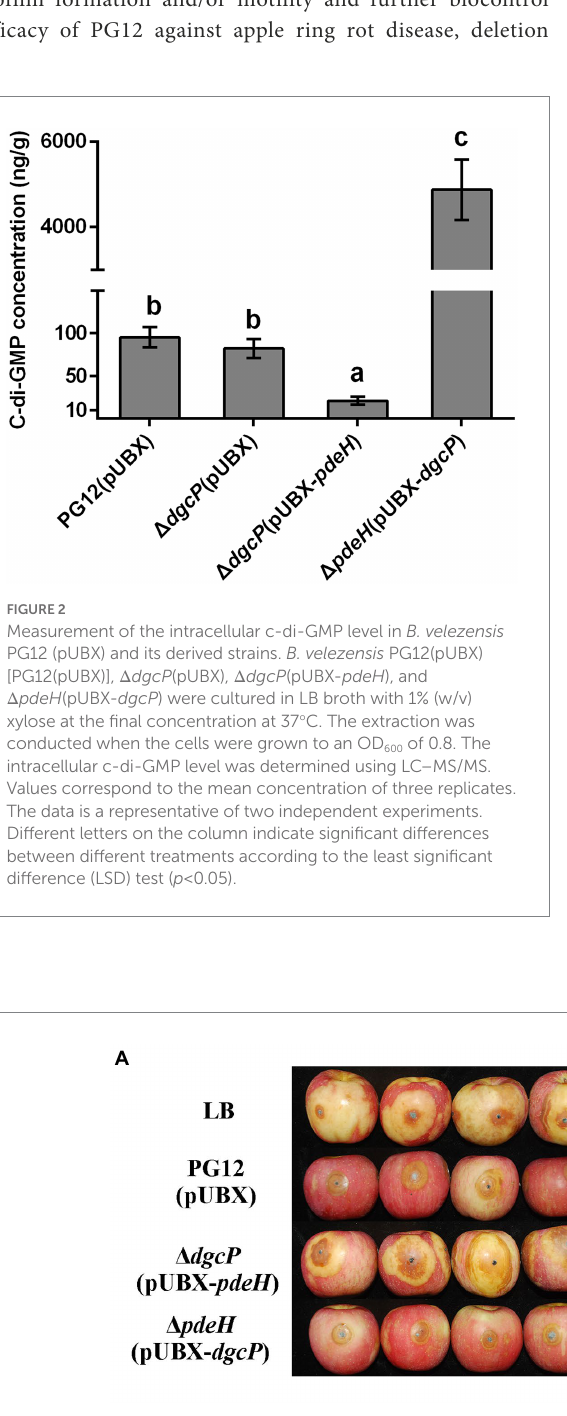
FIGURE 3 Artificially elevated or reduced c-di-GMP changes the biocontrol efficacy of B. velezensis against apple ring rot disease. Bacteria were incubated for 48 h in LB broth supplemented with 1% (w/v) xylose at the final concentration. Biocontrol efficacy was assessed with Fuji apple fruits treated with the cultures of B. velezensis PG12(pUBX) [PG12(pUBX)], Δ dgcP (pUBX- pdeH ) or Δ pdeH (pUBX- dgcP ). Apple fruits soaked with the LB broth (LB) were used as controls. Images were taken (A) and the diameter of disease lesions (B) was measured 7 days post inoculation. Values correspond to the